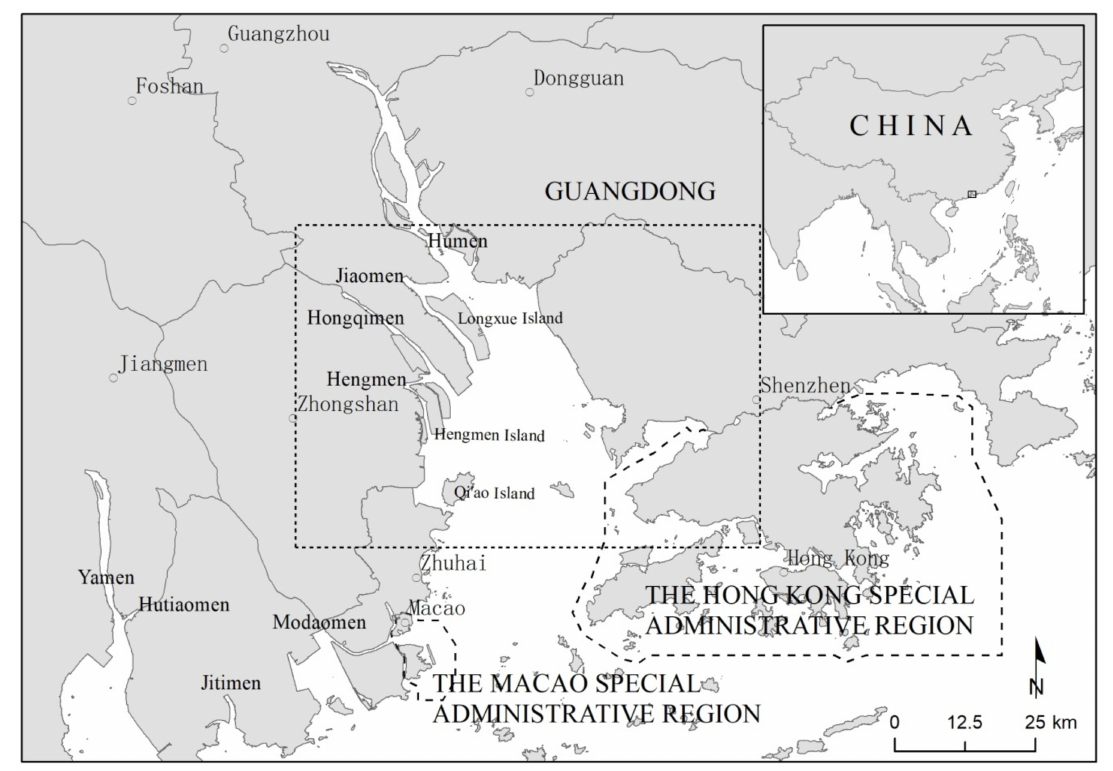
Figure 1. Map of geographical scope in the study area (dashed rectangle in the figure).